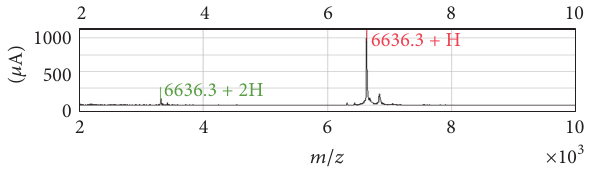
Figure 4: Peaks of mass-to-charge ratio ( m/z ) 6,626 after purifica- tion. The lower peak is the dication of m/z